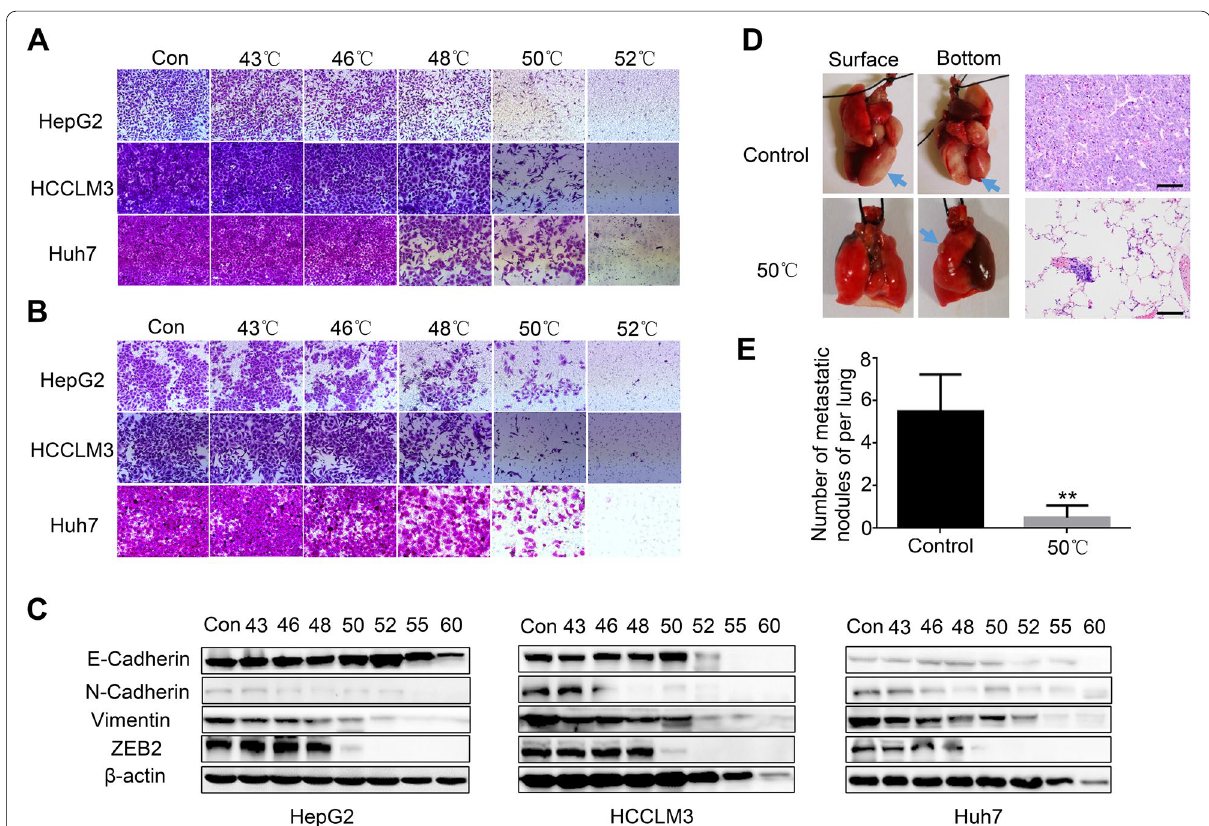
Fig. 7 Hyperthermia inhibits HCC migration and invasion in vitro and in vivo. A Representative images of migration assays for HCC cells in different groups. B Representative images of invasion assays for HCC cells. C E-cadherin, N-cadherin, Vimentin and ZEB2 expression evaluated by western blotting in HCC cells. D Holistic view and H&E staining of excised lungs from a mouse model of metastasis. Representative images of lung tissues were shown in the left panel. Arrows indicate the location of metastatic lung foci. Corresponding H&E staining of metastatic lung foci were shown in the right panel. The scale bar 100 μm. E Incidence of metastatic lung nodules of each group. ** p < =